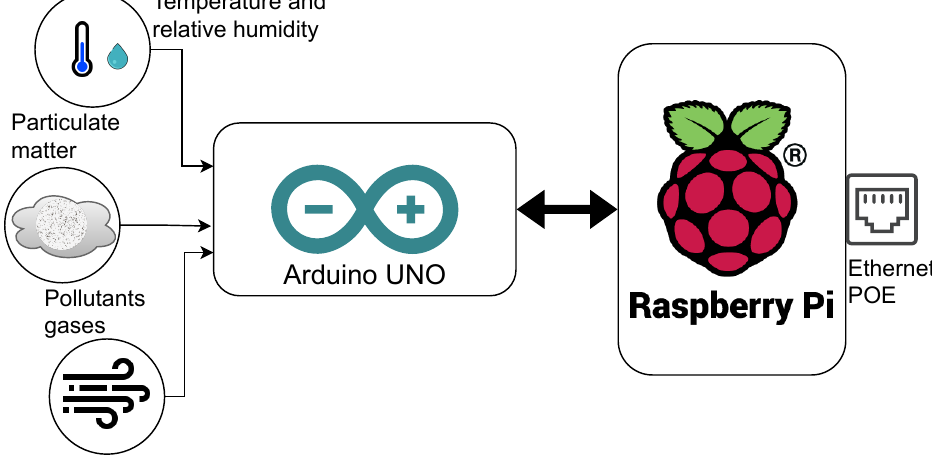
Figure 6. IoT smart sensor basic